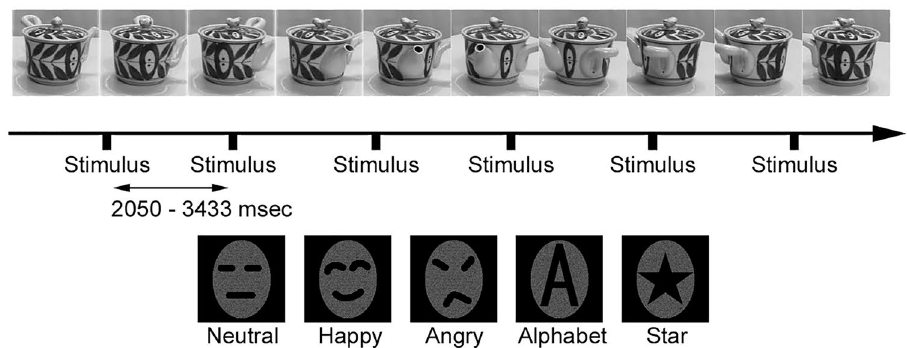
Figure 3. The background moving image of a ‘rotating teapot’ (top) and the examples of stimulus conditions (bottom) modified from our previous study 42 . The time of the inter-stimulus interval (ISI) was random within 2050–3433 ms. Examples of stimulus conditions. Neutral: neutral face stimuli, Happy: happy face stimuli, Angry: angry face stimuli, Alphabet: images of A, B, C, D, E, and F, Target: images of a star. The subjects were asked to push a button as quickly as possible when the target stimuli were presented. Images of face stimuli (Neutral, Happy, and Angry) in Fig. 3 were schematic faces made by the corresponding author, but real face images of Japanese (ATR Promotions, Inc., Kyoto, Japan), which had no hair, ears, or neck (3 male and 3 female faces), were used in the EEG recording and psychological tests, and the favor rating test of this